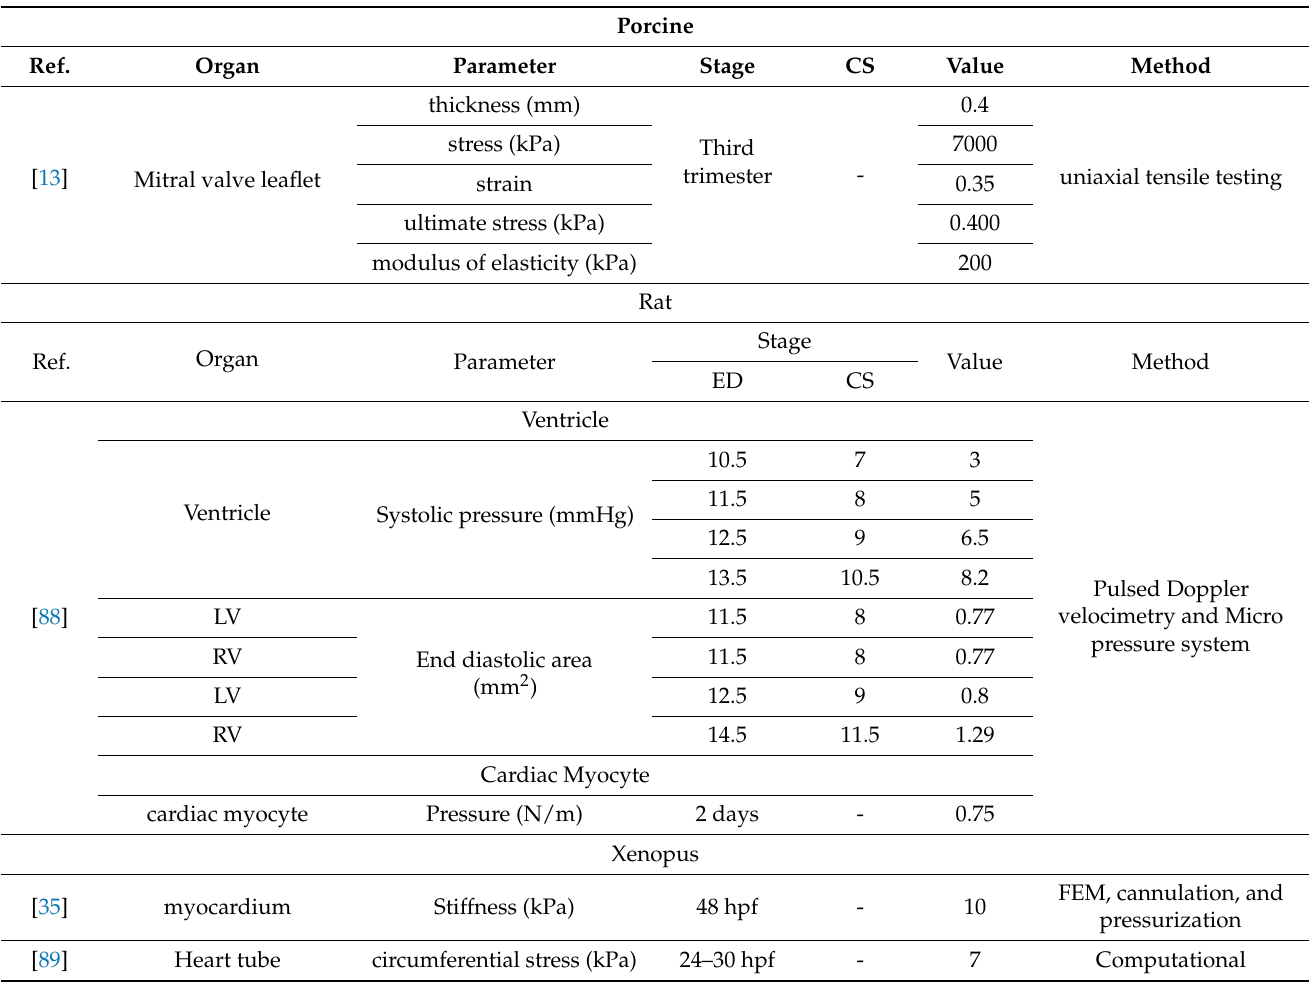
Table 4. Summary of the material properties for swine, rat, and Xenopus models during embryonic development. Embryonic stages for mice are recorded using the ED scale (embryonic day). ED0 is the day of fertilization, followed by ED1, ED2, etc. Similarly, for Xenopus , a scale measuring the number of hours post fertilization is used. As a general reference, CS is also provided. LV: left ventricle, RV: right ventricle, CS: Carnegie stage, ECG: electrocardiography, hpf: hours post fertilization.